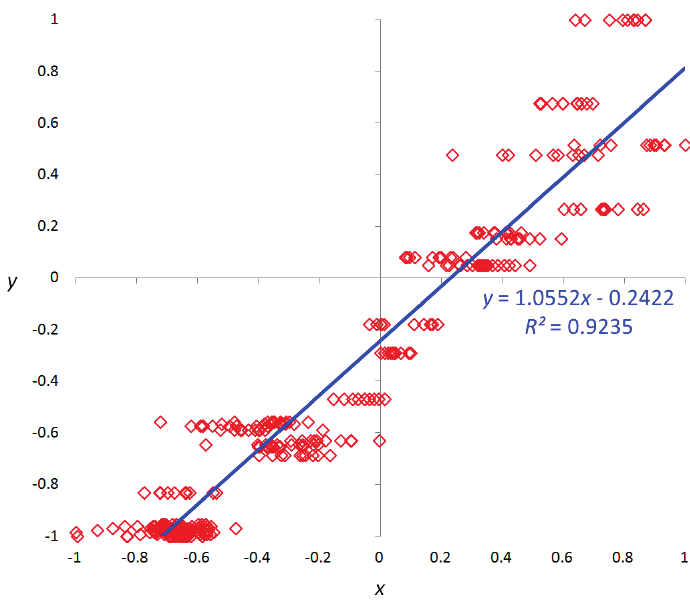
Figure 4. Example of linear regression analysis on two variables of x and y